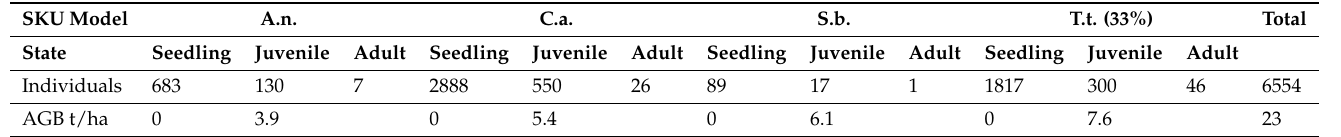
Table 4. Tree initialization in the SKU